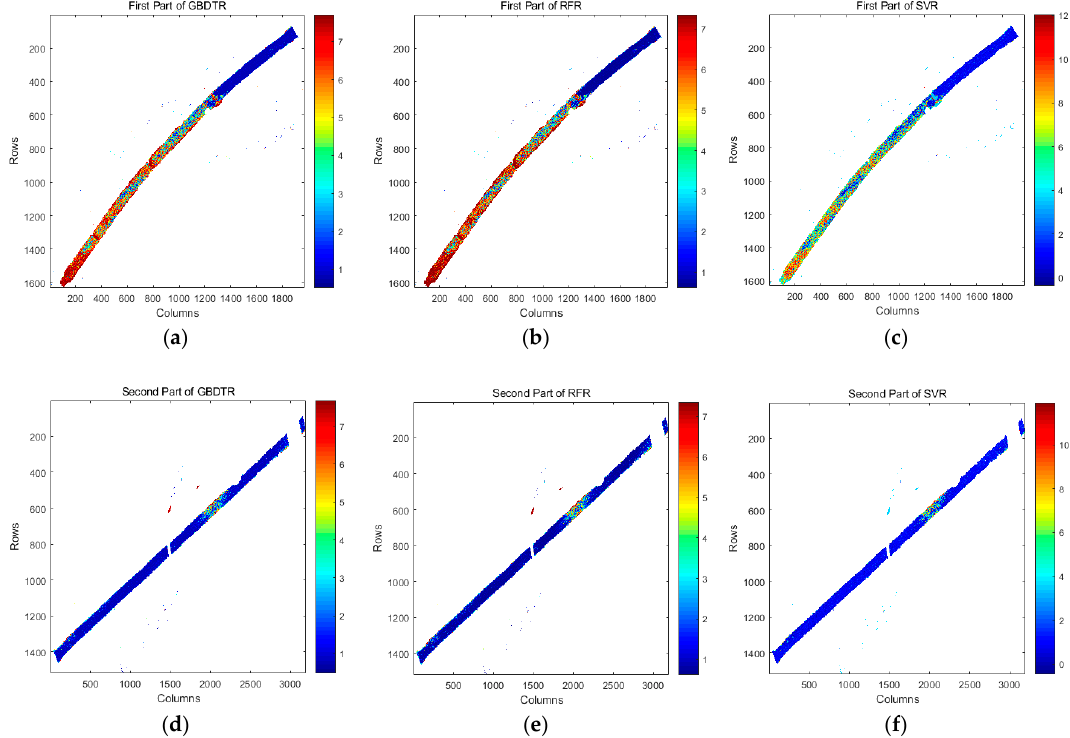
Figure 10. Spatial distribution of the Nemerow index based on the different models in the Shahu Port dataset: ( a , d ) GBDTR, ( b , e ) RFR, ( c , f ) SVR. Table 3. Statistical information of the UAV-borne image inversion based on the different models in the Shahu Port dataset.